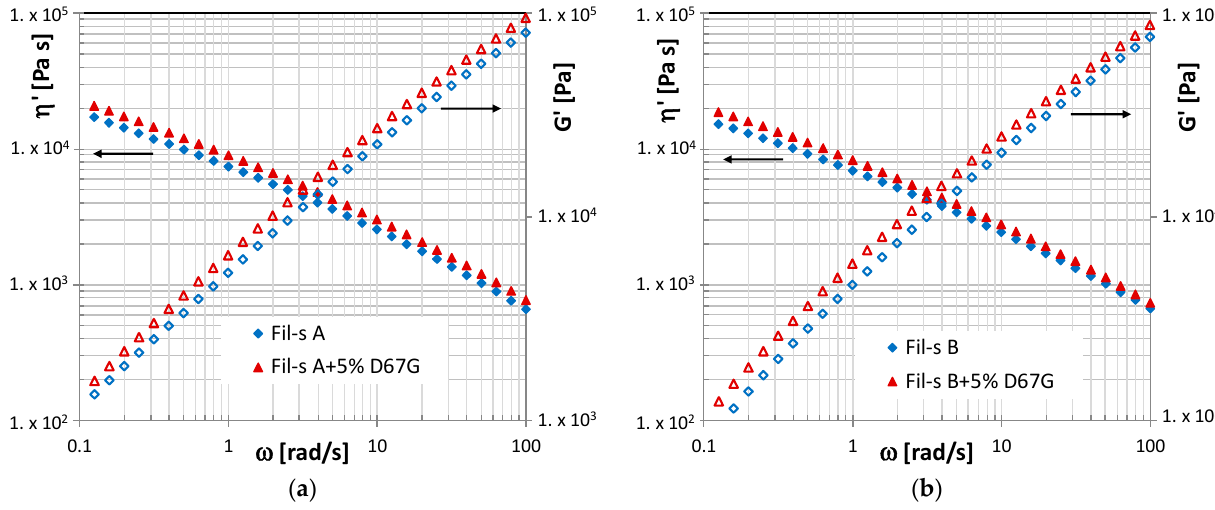
Figure 3. Comparison of the dynamic viscosity ( η ’) and storage modulus (G’) plots of Fil-s A ( a ) and Fil-s B ( b ) and the corresponding nanocomposite systems with Dellite 67G.